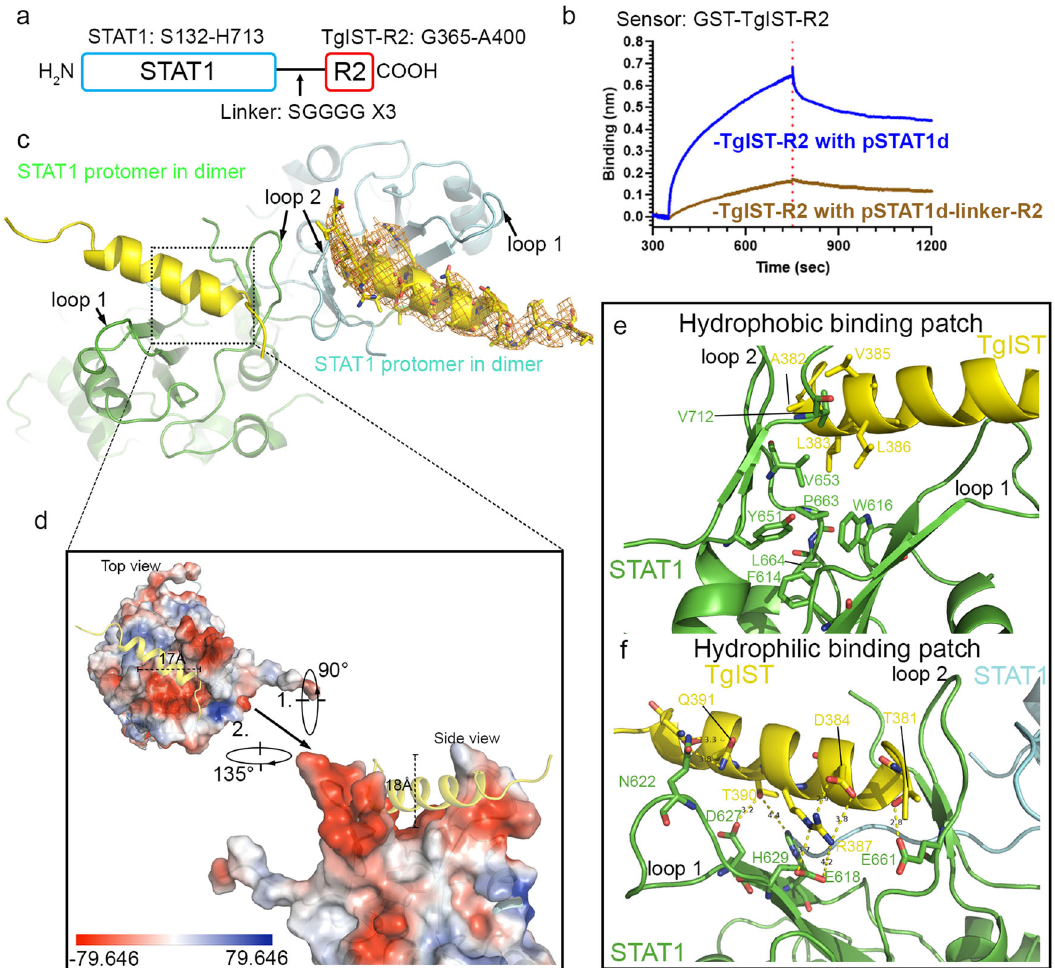
Fig. 5 Molecular interactions between TgIST-R2 and STAT1 dimer revealed by structural studies. a Schematic diagram of the STAT1-linker-R2 fusion protein (STAT1-TgIST-R2). The arrow indicates the fl exible peptide linker. b BLI sensorgrams using biosensor loaded with recombinant GST-TgIST-R2 and interacted with pSTAT1d or pSTAT1d-linker-R2, both at 50 nM concentration. c Crystal structure of TgIST-R2 with STAT1 dimer based on the fused peptide construct shown in ( c ). The peptide backbones of two STAT1 protomers within the dimer are shown in cyan and green loops while the TgIST peptide is shown in yellow ribbon. Orange mesh represents the 2Fo-Fc map of TgIST-R2 contoured at 1.5 σ . d Electrostatic potential surface representation of the TgIST binding region in STAT1. e , f Direct interactions between TgIST-R2 and STAT1 at the binding interface. The yellow dashed lines indicate salt bridges or hydrogen bonds between corresponding atoms within 2.8 – 4.2 Å, with the exception of the 4.4 Å between TgIST-T390 and STAT1-H629. Source data are provided in the Source Data fi